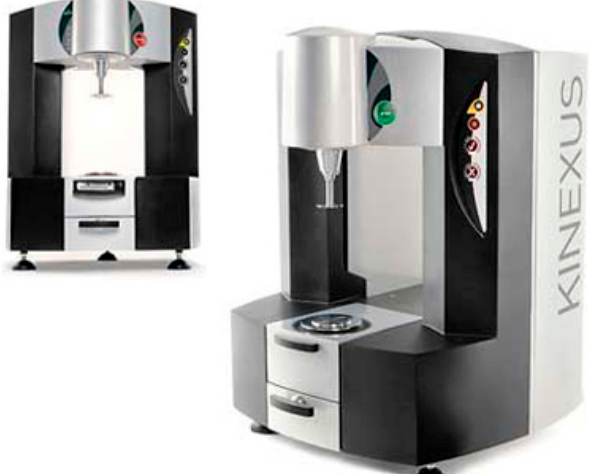
Figure 2. The general view of the rotary rheometer «Kinexus ultra+».